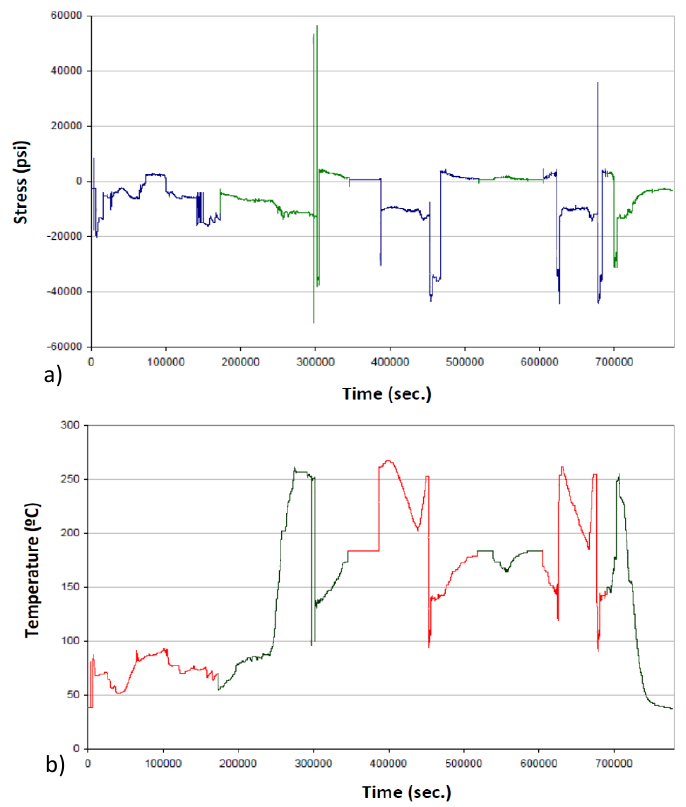
Figure 2. ( a ) Evolution of a particular stress component provided by a monitoring system in a Safe End; ( b ) evolution of the temperature at the same timing and location. The sequence includes six consecutive design transients (corresponding to the different colored lines) [36].